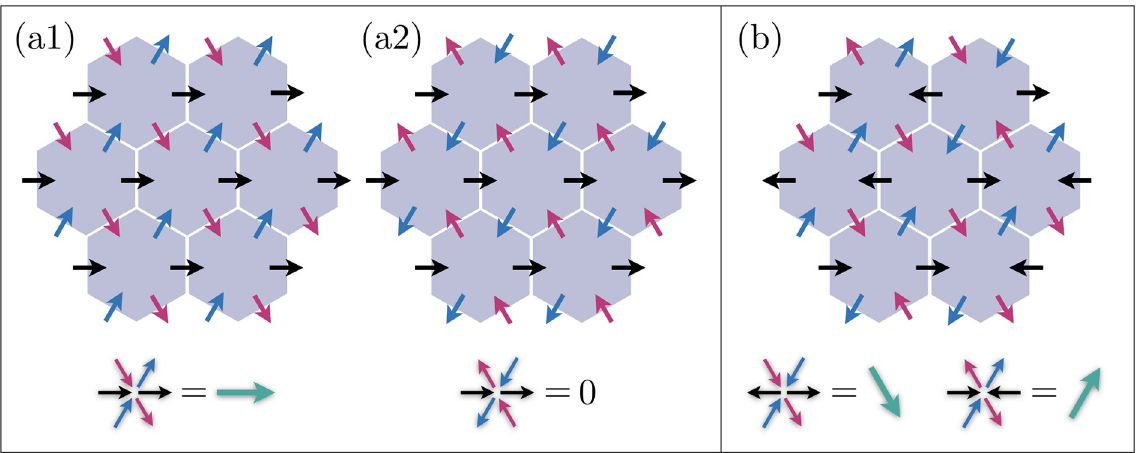
Fig 2. Cartoons of the trivial (a1, a2), and (b) nontrivial patterns. Trivial patterns exhibit uniform polarity across the tissue. While the polarization pattern in (a1) is highly stable, the one in (a2) is immediately destabilized by slightest nonlocal cytoplasmic interactions. In (b) all junctions are polarized with equal magnitudes, yet the cell dipoles are oriented randomly with little correlation; two dipoles belonging to the central cell and its right neighbor are shown.